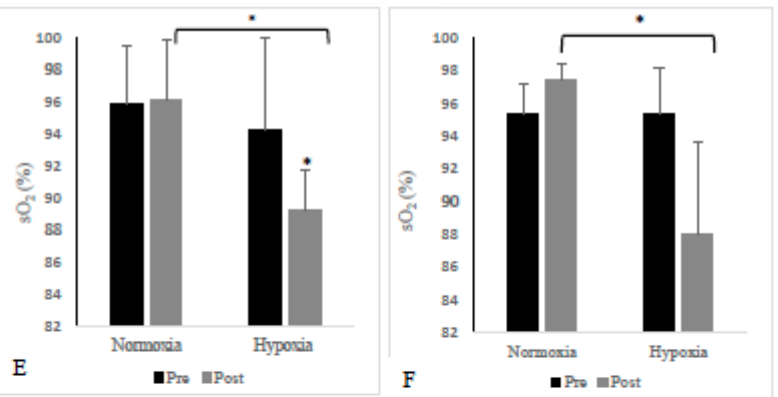
Figure 1. Mean pre- and post-exercise blood gas measurements for the two sprint training protocols (12 × 5 versus 3 × 20). ( A ) partial pressure of carbon dioxide (pCO 2 ) in the 12 × 5 protocol; ( B ) partial pressure of carbon dioxide (pCO 2 ) in the 3 × 20 protocol; ( C ) partial pressure of oxygen (pO 2 ) in the 12 × 5 protocol; ( D ) partial pressure of oxygen (pO 2 ) in the 3 × 20 protocol; (E) blood oxygen satura- tion (sO 2 ) in the 12 × 5 protocol; ( F ) blood oxygen saturation (sO 2 ) in the 3 × 20 protocol. Data are mean ± SD. *Significant difference versus normoxia, independent of training protocol ( p < 0.05).